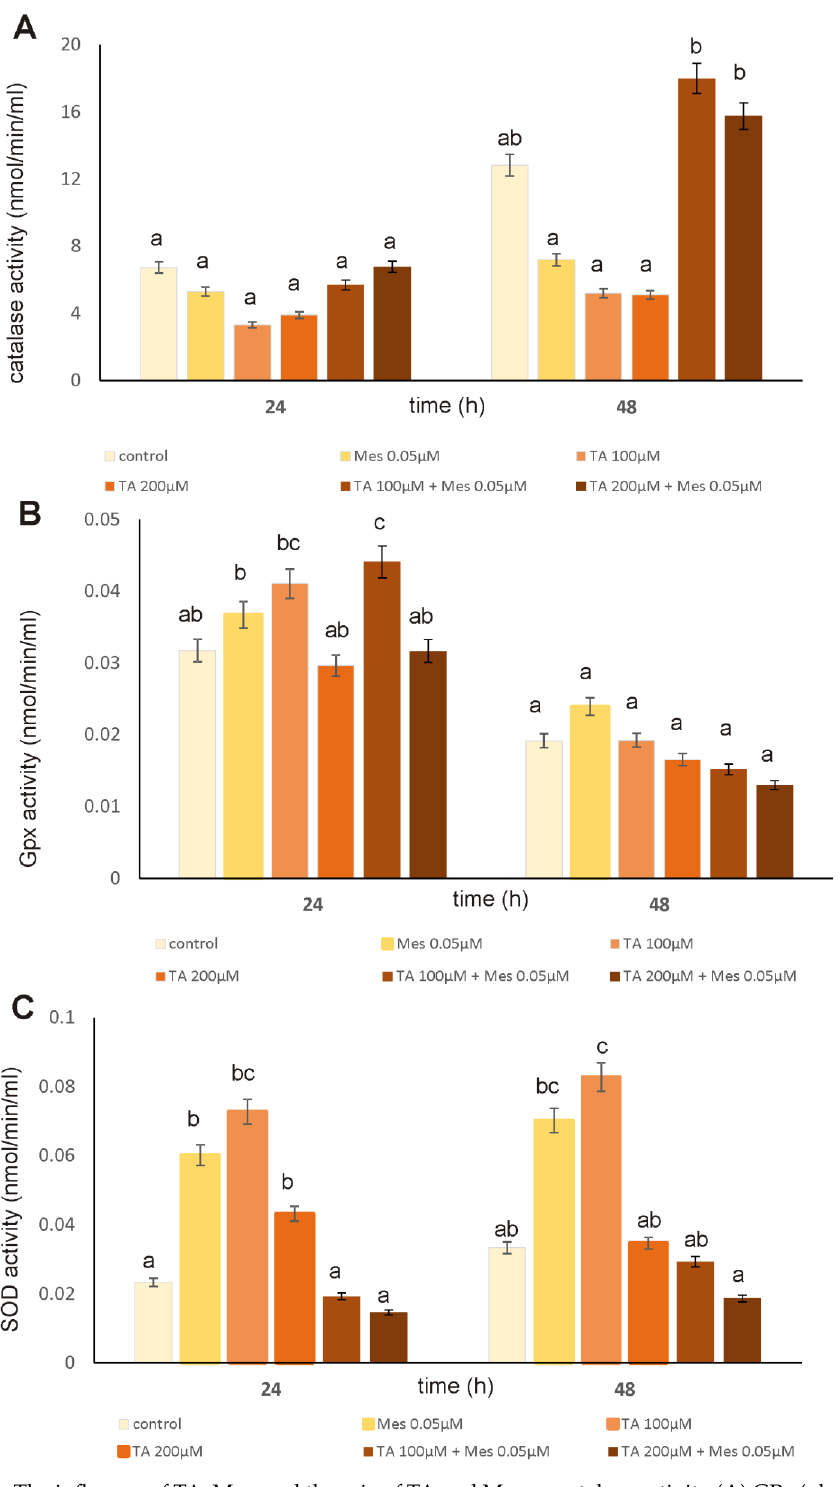
Figure 6. The influence of TA, Mes, and the mix of TA and Mes on catalase activity ( A ) GPx (glutathione peroxidase) activity ( B ) and SOD (superoxide dismutase) activity ( C ) in ZR-75-1 cells. The cells were cultured with 100 µM of TA, 200 µM of TA, 0.05 µM of Mes, and a mix of 100 µM TA + 0.05 µM Mes, 200 µM TA + 0.05 µM Mes for 24 h and 48 h. Mean values from three independent experiments ± SD are shown. Different letters indicate statistical differences ( p ≤ 0.05) between each treatment estimated by Tukey’s test.